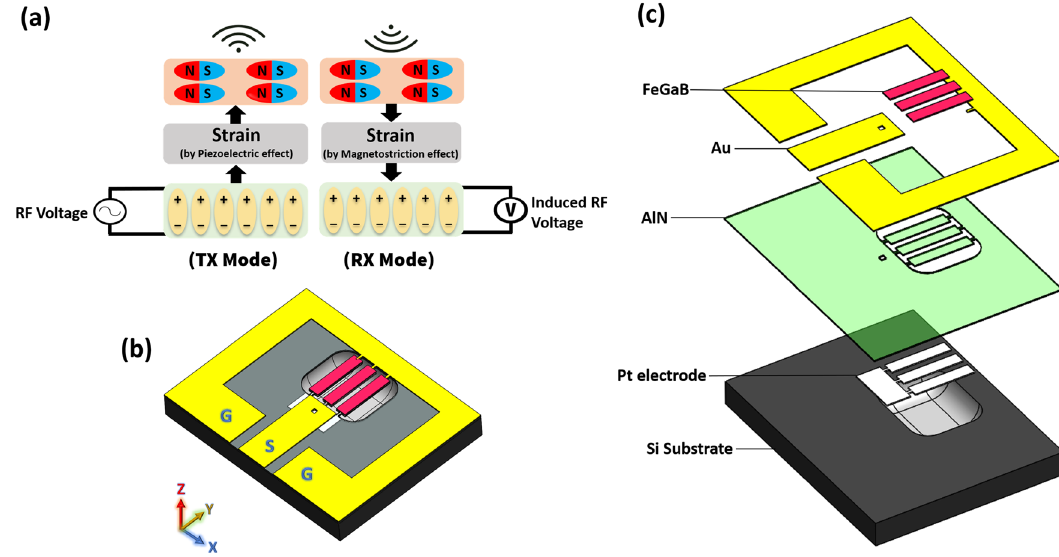
Fig. 1 3D structure and operating concept of the proposed ME antenna. a Diagram showing the concept of Tx and Rx operating modes of ME antenna, where the top and bottom rectangular boxes represent the magnetostrctive and piezoelectric layers, respectively; b 3D schematic of the ME antenna on released Si substrate. The yellow color indicates a gold ground ring and GSG pads that are used for probing and wire-bonding the antenna to PCB; c exploded structure of the ME antenna showing all the